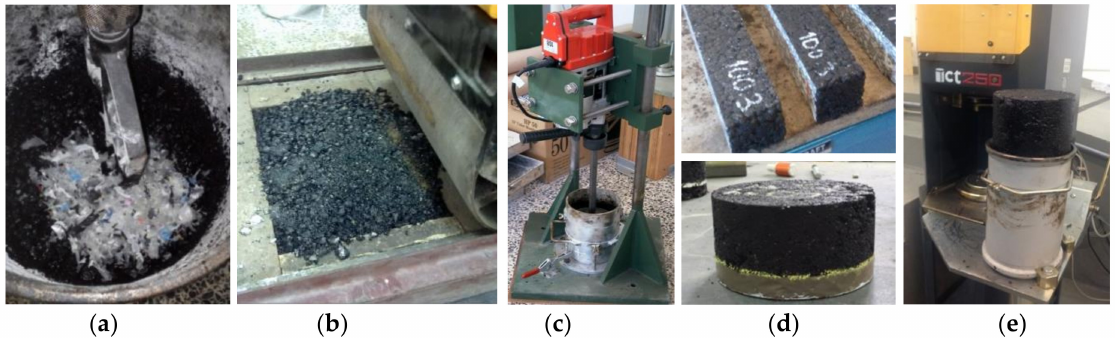
Figure 4. View of the mixing procedure and production of specimens: ( a ) incorporation of plastic waste by the dry process; ( b ) compaction of slabs with a tandem roller; ( c ) compaction of cylin- drical specimens with a vibrating hammer; ( d ) prismatic and cylindrical specimens to mechanical performance evaluation; ( e ) gyratory compactor and cylindrical specimen